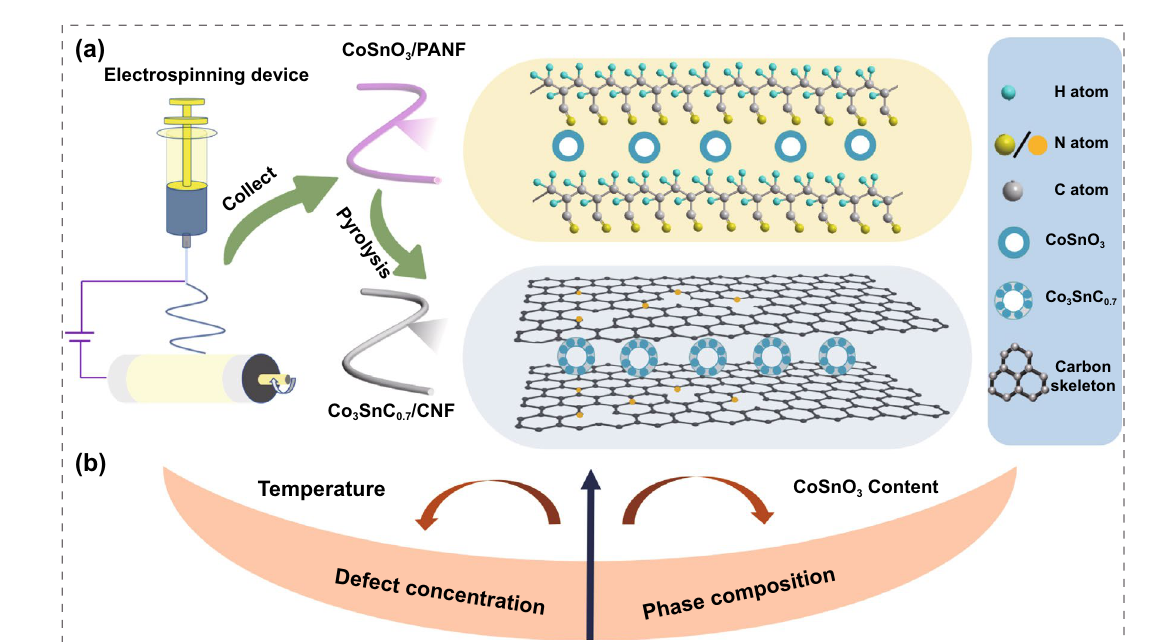
Fig. 1 Schematic illustration of the synthesis of Co 3 SnC 0.7 /CNF ( a ); the relationship between temperature and content on defect concentration and composition of samples ( b )